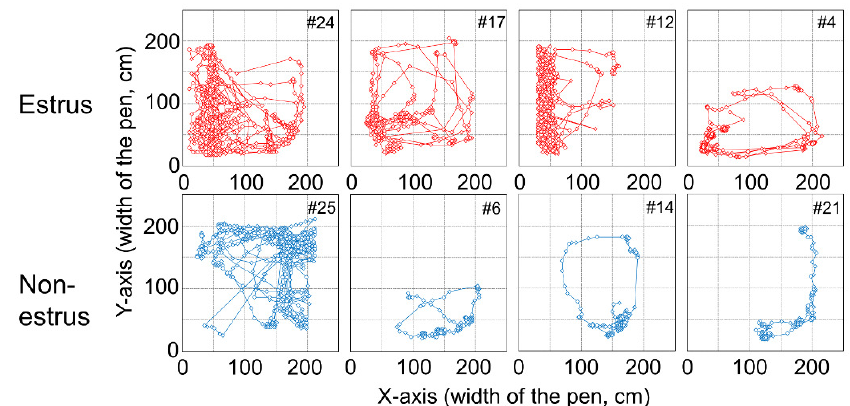
Figure 4. Tracking data of female goats in estrus and non-estrus. The x -coordinate of a female goat tends to be smaller when the female goat is in estrus and larger when the goat is in